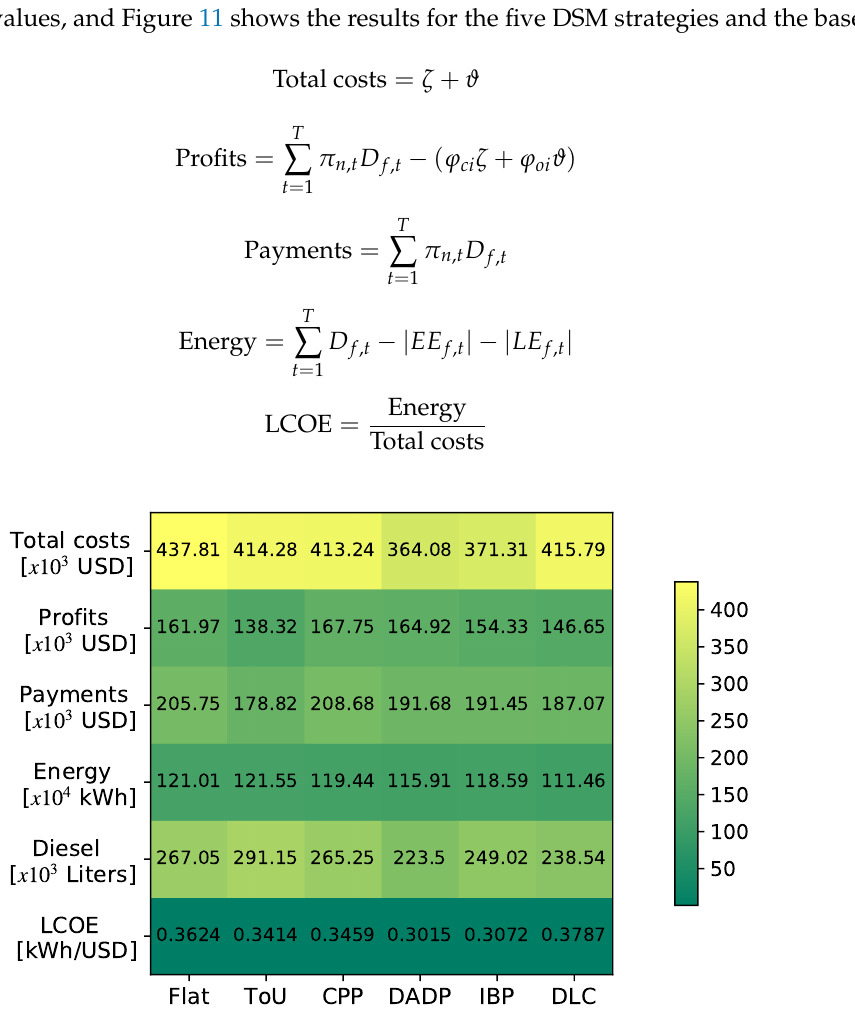
Figure 11. Comparison of the costs and the Levelized Cost of Energy (LCOE) of the five DSMs against the base